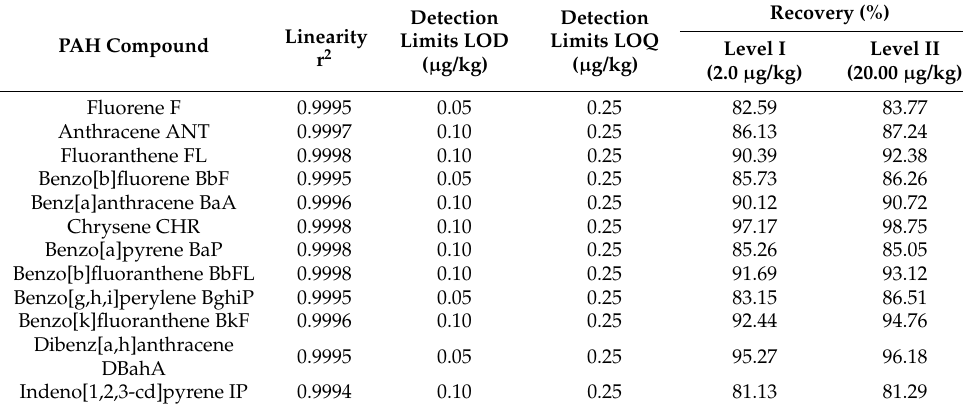
Table 4. The method validation